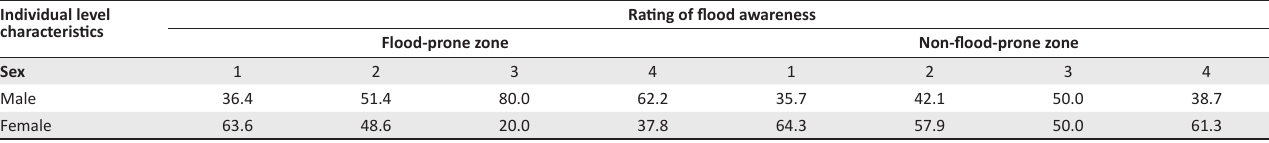
TABLE 5: Relationship between individual’s gender and rating of flood awareness . Individual level characteristics